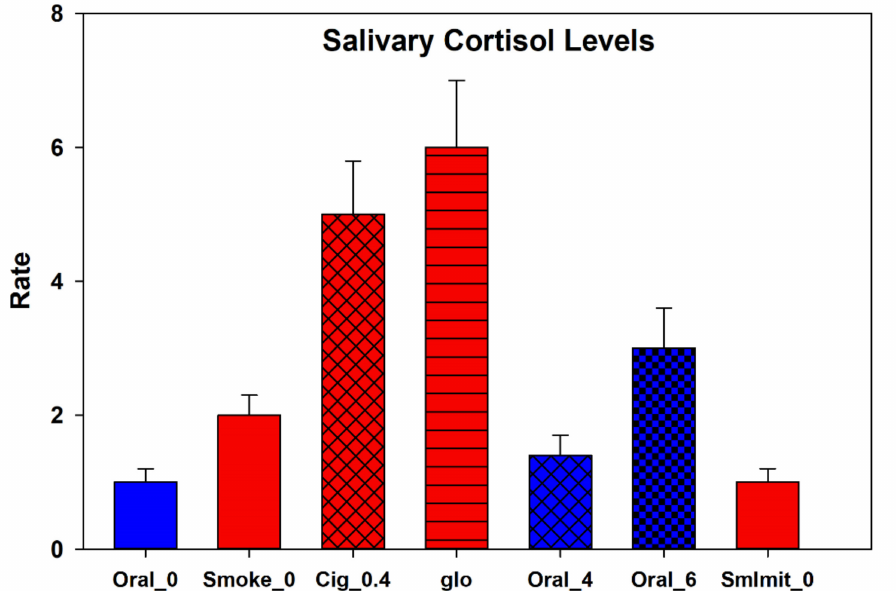
Figure 10. The maximum changes in the level of cortisol (relative to the baseline) in the saliva of a volunteer after testing different types of nicotine and nicotine-free products and the imitation of smoking. Experimental data acquired with oral nicotine products (packs with a nicotine content of 0.4 and 6 mg) are given in blue, while the data obtained for products with an inhalation mod for the nicotine delivery are marked in red (CC refers to a conventional cigarette with nicotine 0.4 mg, glo denotes the glo TM tobacco heating system and a nicotine-free cigarette is designated as Smoke_0, while SmImit is for the imitation of smoking with an unlit cigarette). Data are presented as means of three measurements with the standard deviation. All experiments were carried out at the same time of the day with an interval of 2 to 3 days between tests. The experiment involved a volunteer from the group of rare smokers (2–4 cigarettes per week with a nicotine content of 0.4